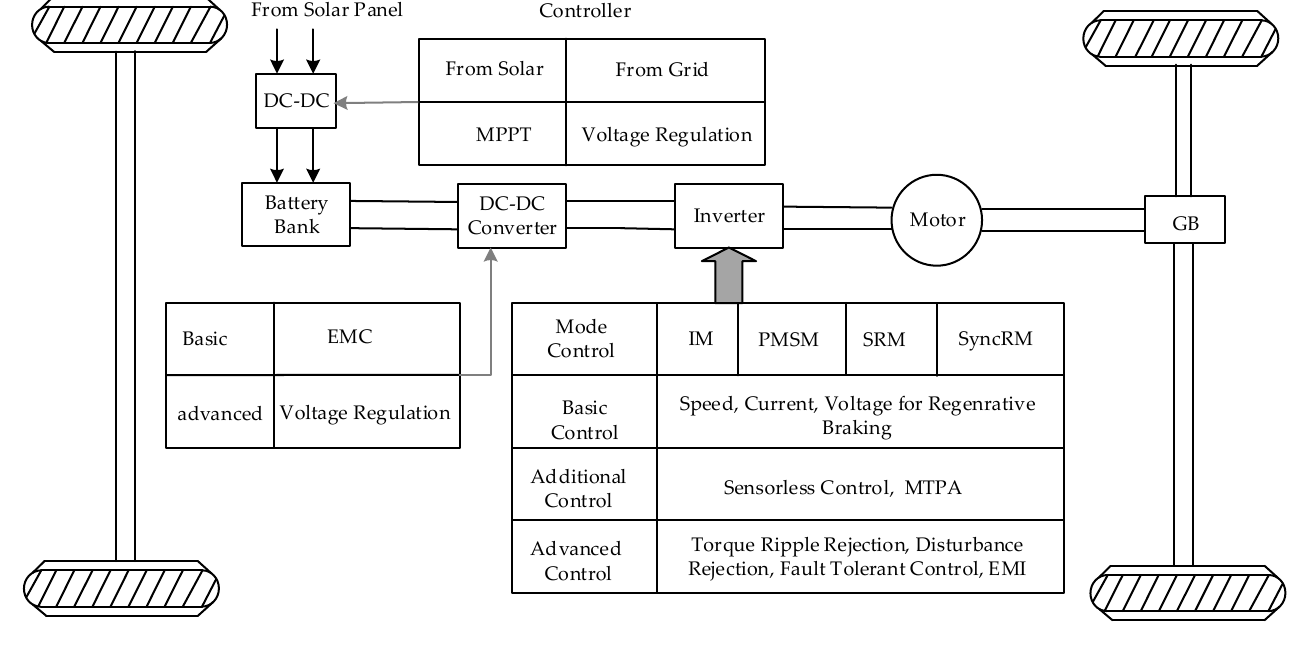
Figure 10. Control strategies deployed in four-wheeler EVs.